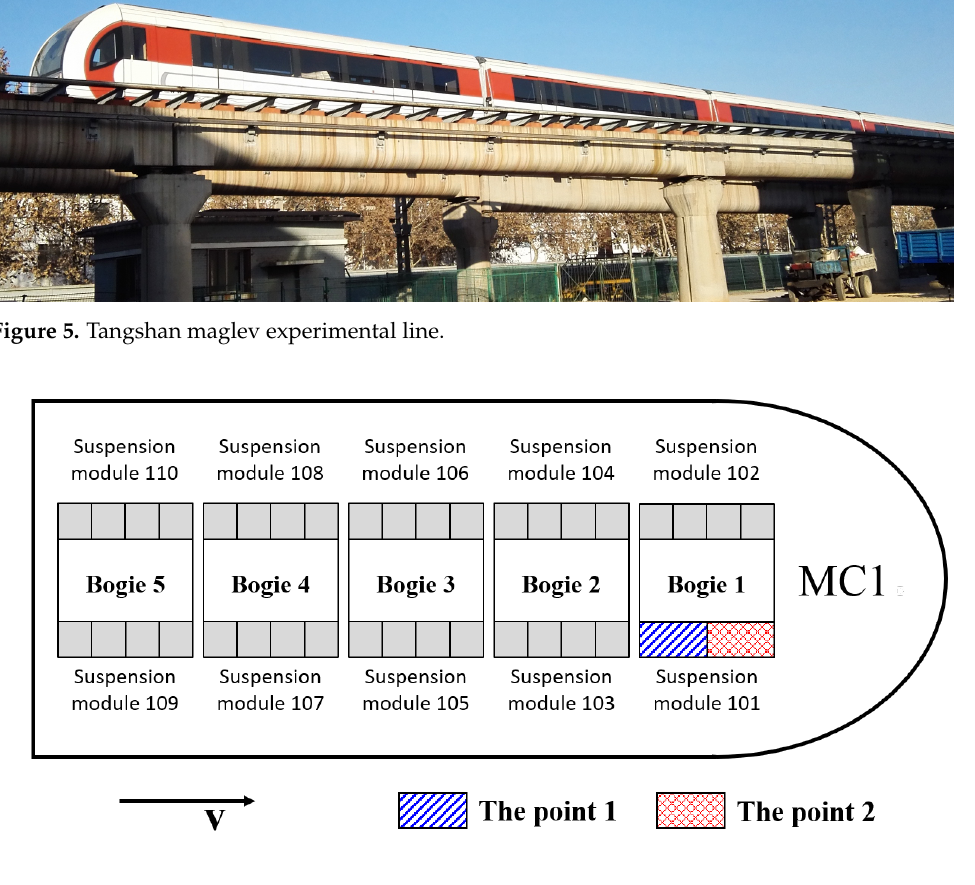
Figure 6. Data acquisition